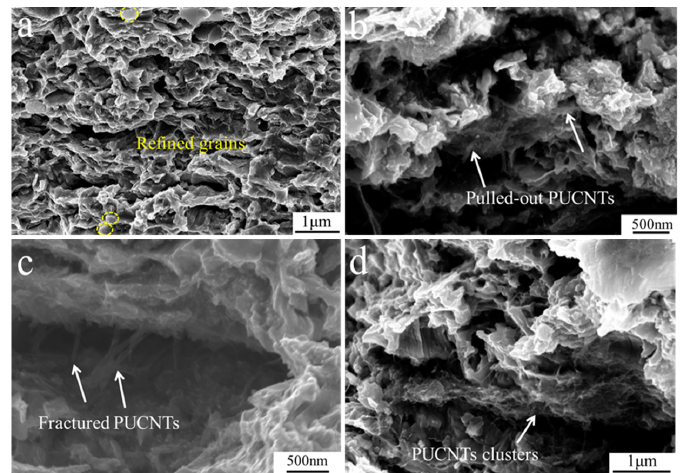
Figure 6. Fracture morphologies of pure Zn and PUCNTs/Zn composites: ( a ) fracture morphologies of pure Zn; ( b ) and ( c ) fracture morphologies of 0.2 PUCNTs/Zn composites; ( d ) fracture morphologies of 0.5 PUCNTs/Zn composites.